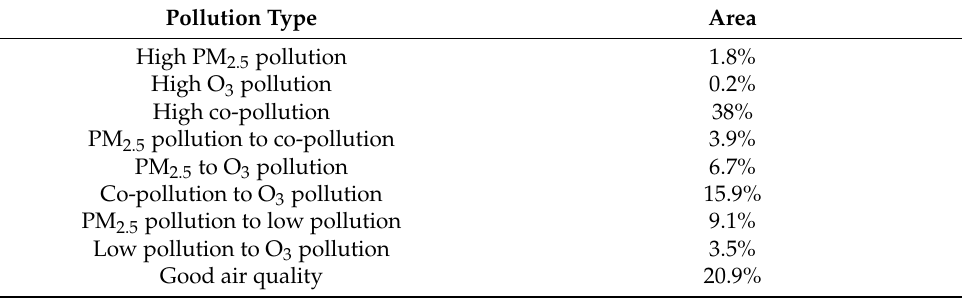
Figure A3. Spatial distribution of O 3 concentration in spring, summer, autumn, and winter (2015–2020 means for each season). Table A3. Proportions of pollution types as defined by pollution